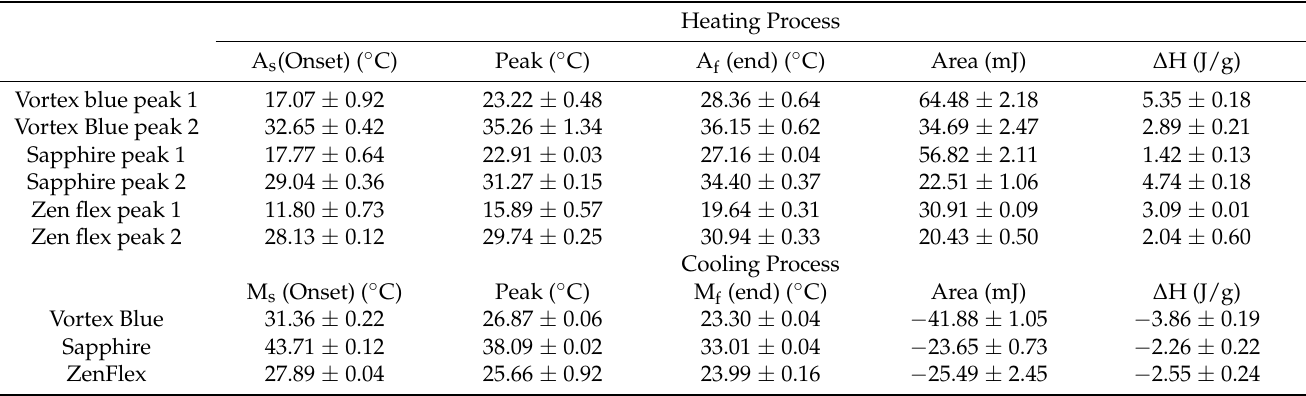
Figure 1. DSC curve of ZF, ESS and VB instruments with a heating/cooling rate of 5 °C. On the heating curves (top lines reading from left to right) two endothermic peaks were recorded for all three instruments, which showed the presence of R-Phase (first peak). On the contrary, a different thermal behavior was observed in the cooling curves (bottom lines reading from right to left), where the instruments showed only one relevant exothermic peak related to the reverse transformation of austenite to martensite. All data regarding TTR, peaks and Δ H are shown in Table 2. Table 2. Phase transformation temperatures and associated energy of VB, ESS and ZF (mean ± SD, n = 3), tested in aluminum